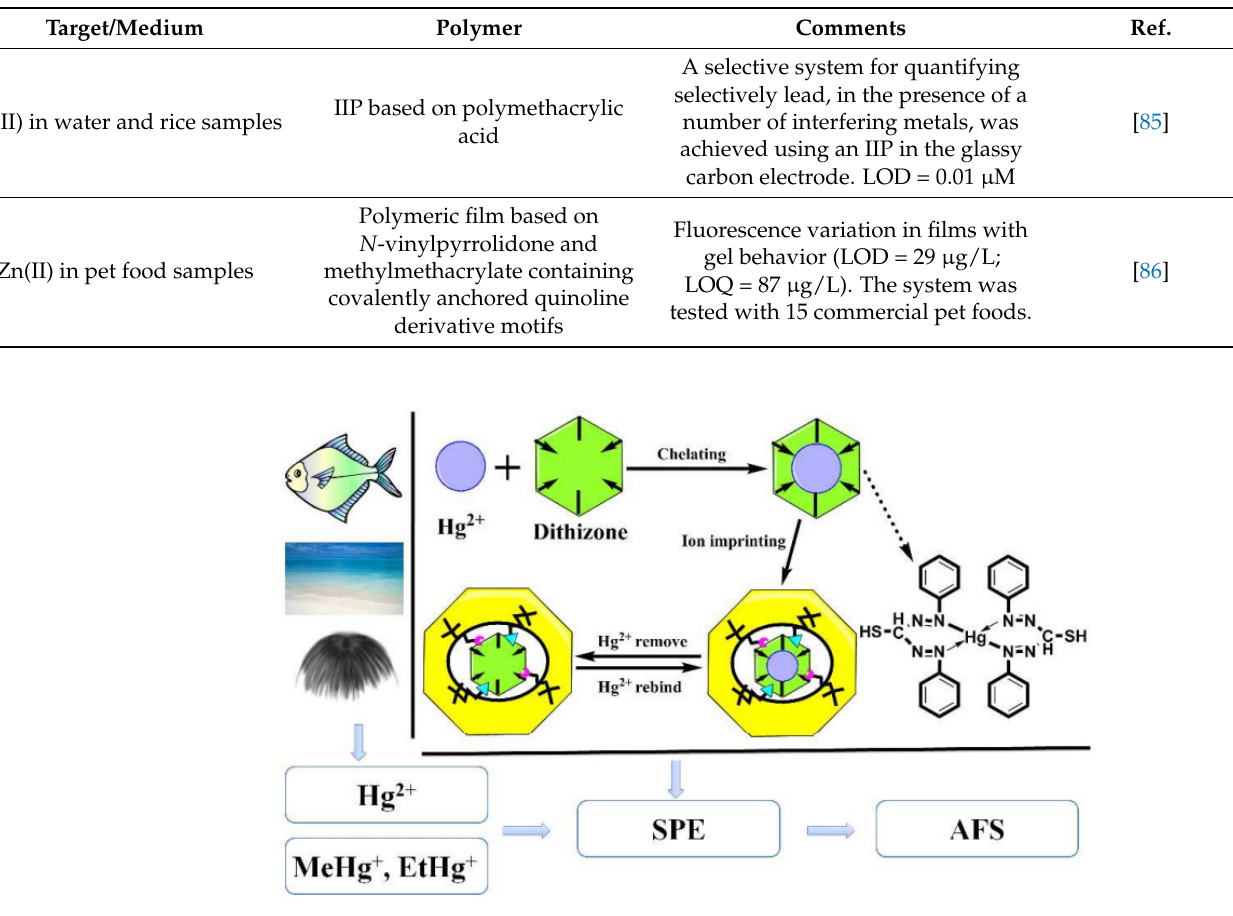
Figure 5. Schematic representation of the preparation of Hg-IIPs via the sol–gel process. The Hg(II) and dithizone complex was prepared in the first place and used as the template molecule. The template was pre-polymerized with functional APTES (a frequently used silane coupling agent in sol–gel processes). Hg(II) was eliminated by elution, leaving the specific recognition site. After Hg(II) or organic mercury is recognized by solid phase extraction (SPE), atomic fluorescence spectroscopy (AFS) is used for detection. Adapted with permission from [79]. Copyright © RSC Publishing 2011.